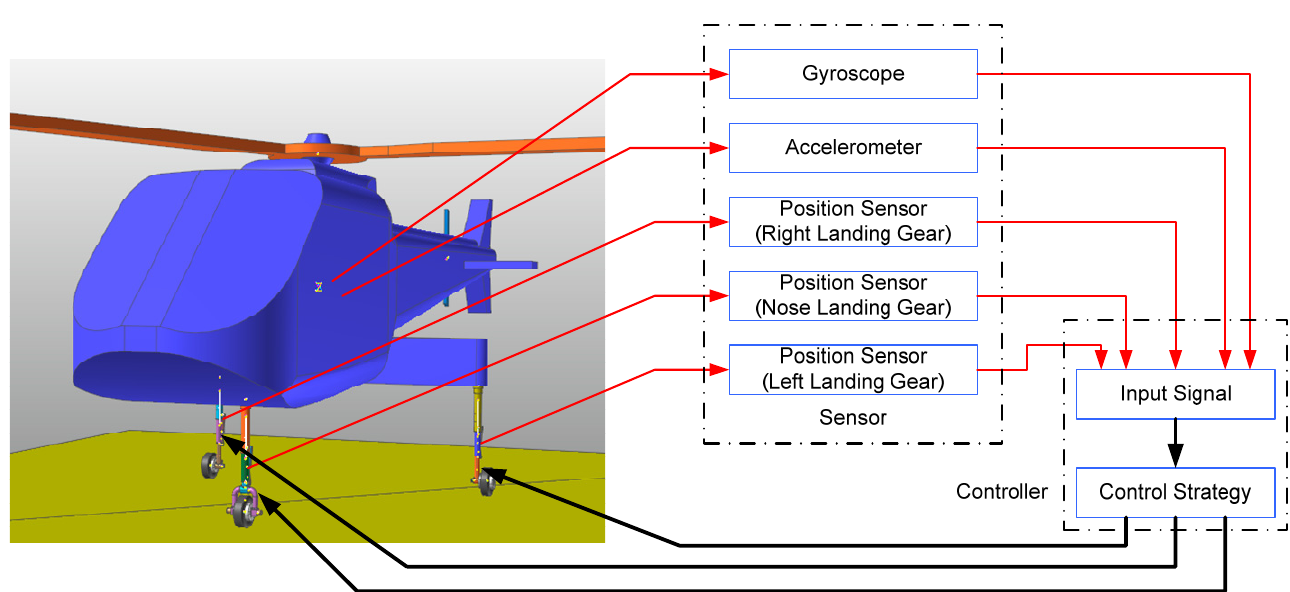
Figure 4. The control architecture of a helicopter landing gear